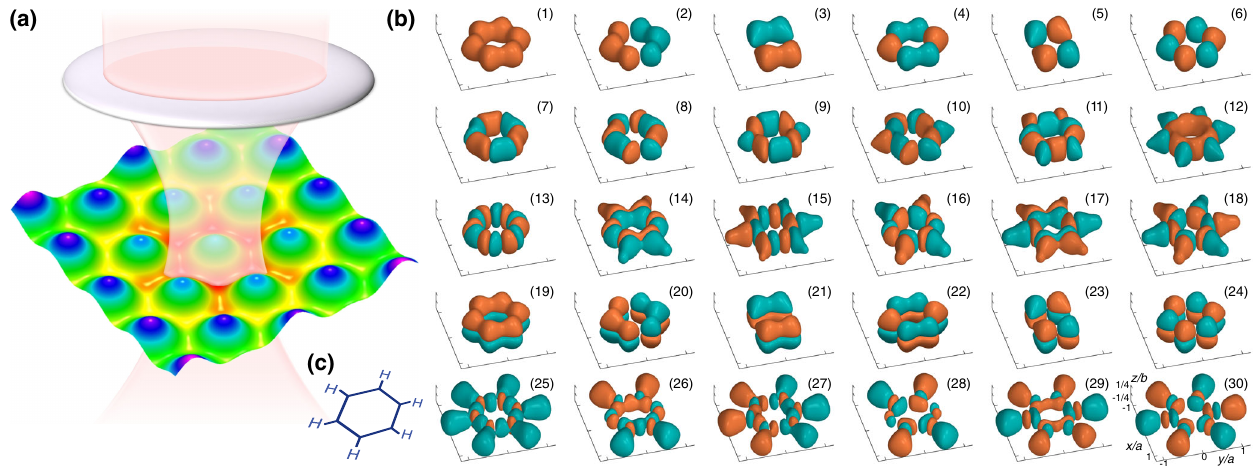
FIG. 1. Molecular orbitals of artificial benzene. (a) Illustration of a honeycomb optical lattice superposed with a dipole trap. The hexagonal ring and the adjacent sites form a trapping potential for an artificial, benzenelike molecule. (b) Calculated molecular single-particle orbitals of the artificial benzene molecule with low-lying s orbitals (1 – 6) on the inner “ C ” ring, hybridized sp 2 orbitals (7 – 18, 25 – 30) including the adjacent “ H ” atoms, and p orbitals (19 – 24) forming a conjugated π system. The orbitals are plotted for the z 35 E lattice depths V 0 ¼ 11 E and V 0 in units of the recoil energy E of the lattice wavelength. The isosurfaces depict the orbital ffiffiffi ffiffiffi p p R z ¼ R R b b wave functions at 0 . 4 =a (orange) and − 0 . 4 =a (green) with the lattice constant a of the honeycomb and b of the orthogonal lattice. (c) Chemical structure of the benzene molecule C 6 H 6